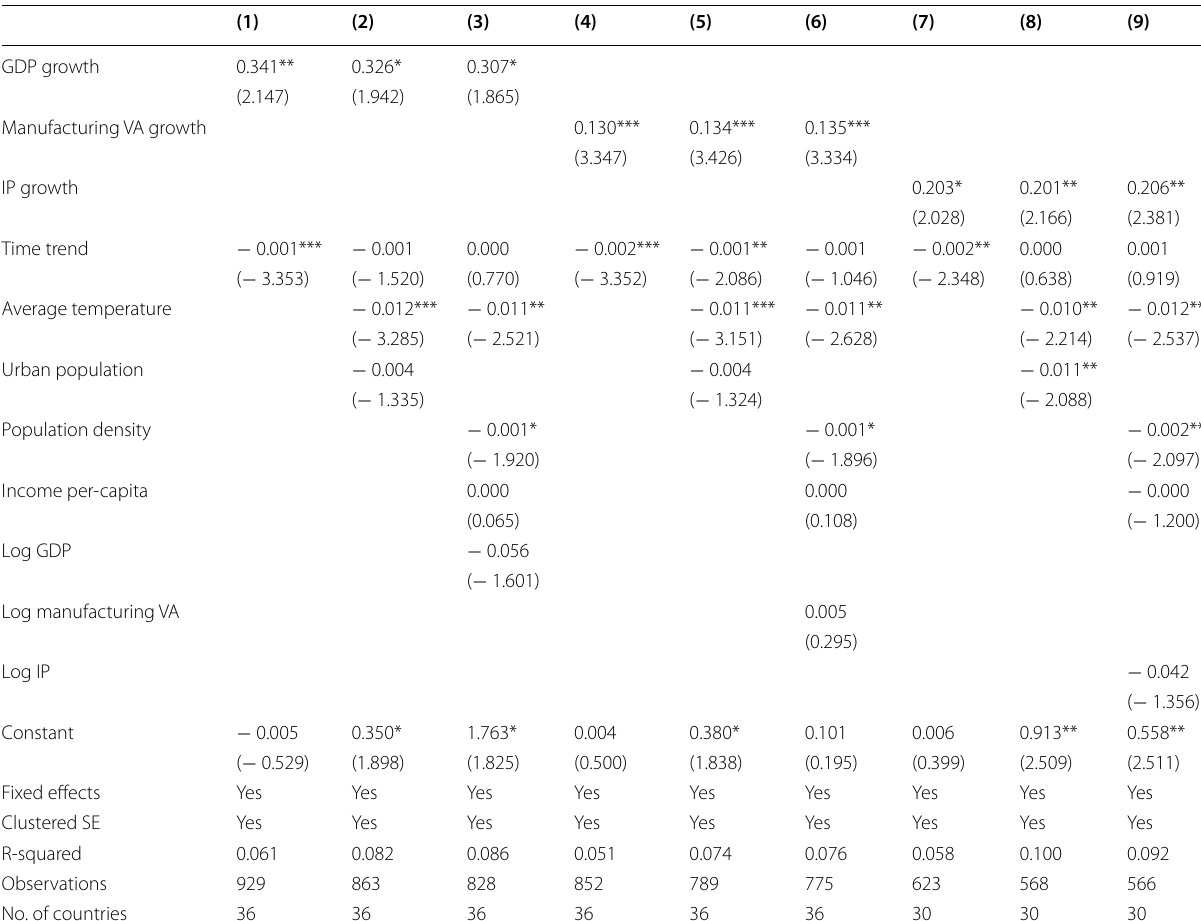
Table 2 NO emissions and economic activity—historical data 2